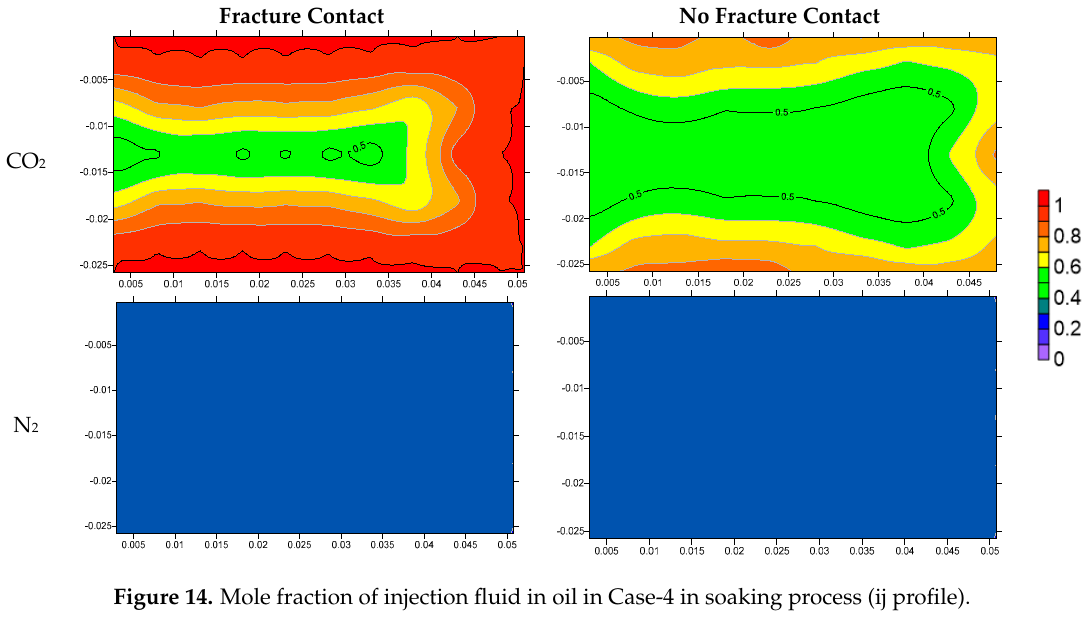
Figure 14. Mole fraction of injection fluid in oil in Case-4 in soaking process (ij profile).